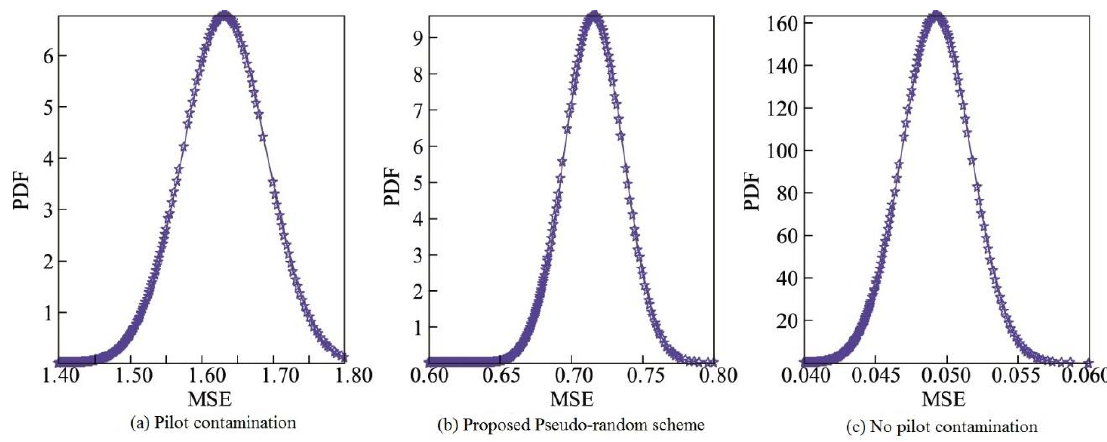
Figure 15. PDF comparison of the proposed pseudo-random code scheme with other cases.